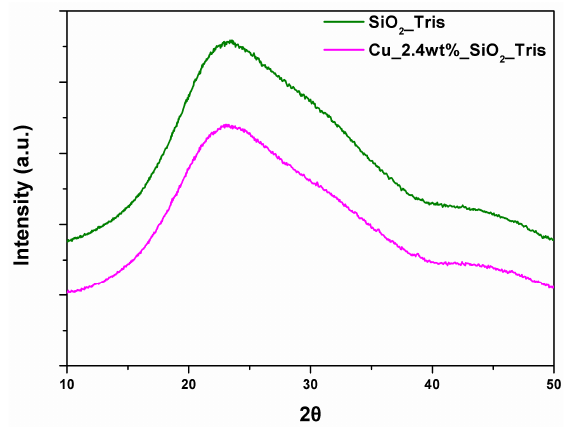
Figure 7. X-ray diffraction (XRD) patterns of samples produced with Tris buffer. Table 2. Typical composition of car exhaust gases in stoichiometric conditions ( λ = 1).